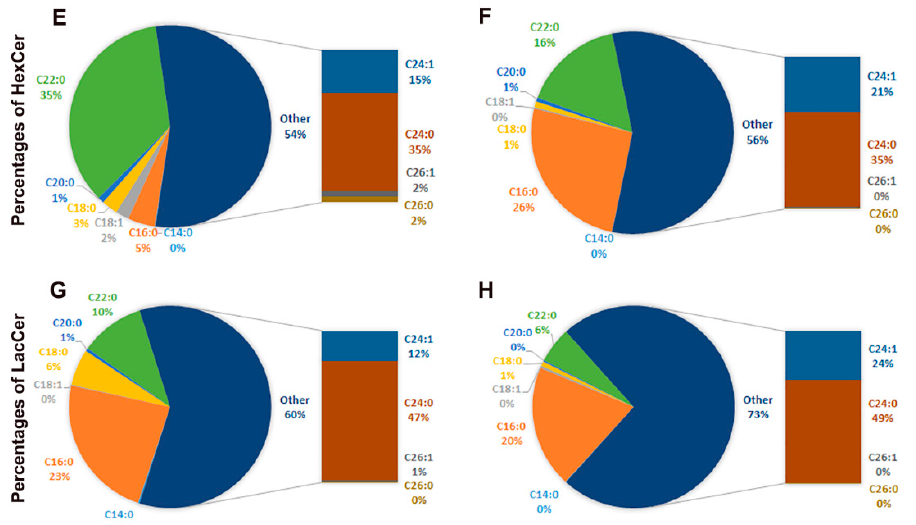
Figure 2. Compositional analysis of major SPL carbon chain length variants in HREC and BV2 cells cultured for 48 h in 5 mM glucose-containing media. Mol% composition of ( A ) Cer, ( C ) SM, ( E ) HexCer, and ( G ) LacCer species in HREC. Mol% composition of ( B ) Cer, ( D ) SM, ( F ) HexCer, and ( H ) LacCer species in BV2 cells. n = 3.